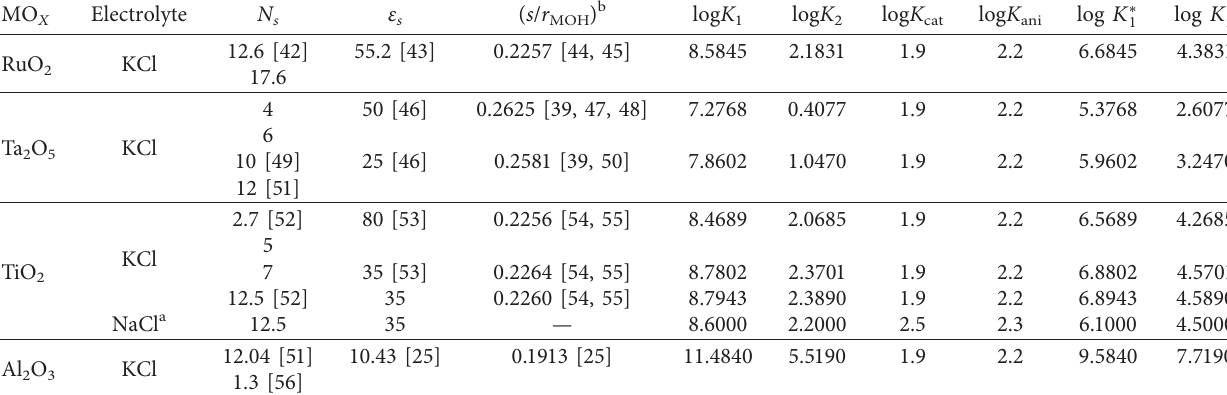
Table 2: TLM and Sverjensky model